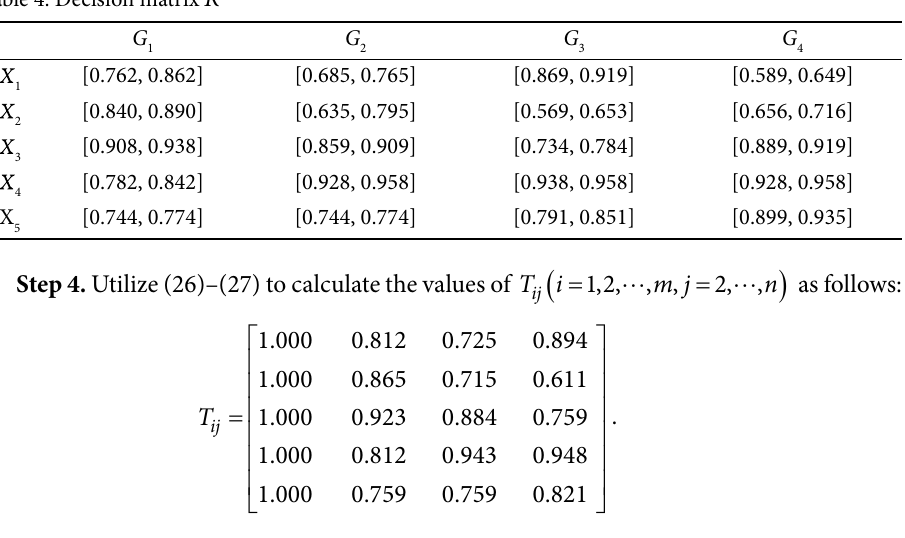
Table 4. Decision matrix R